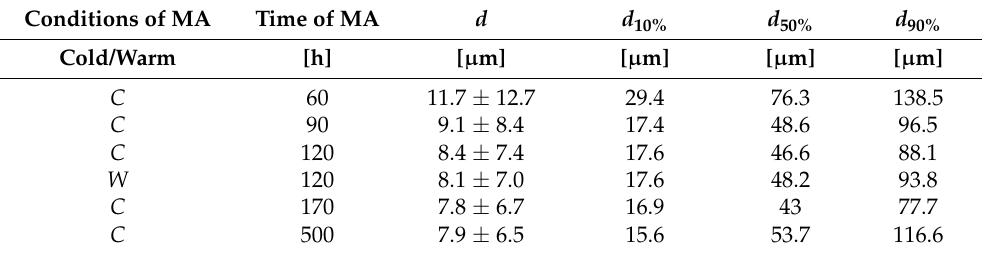
Figure 2. Distribution functions representing ( a ) log-normal size distribution of powder particles detected at the metallographic cut and ( b ) Volume Weighted Cumulative Frequency (VWCF) of powder particle sizes. Table 1. Characterization of powder particle sizes distribution calculated from log-normal size distribution (see Figure 2a) and volume-weighted sieving parameters d X % for 10, 50, and 90% values determined from volume-weighted cumulative frequency (see Figure 2b).